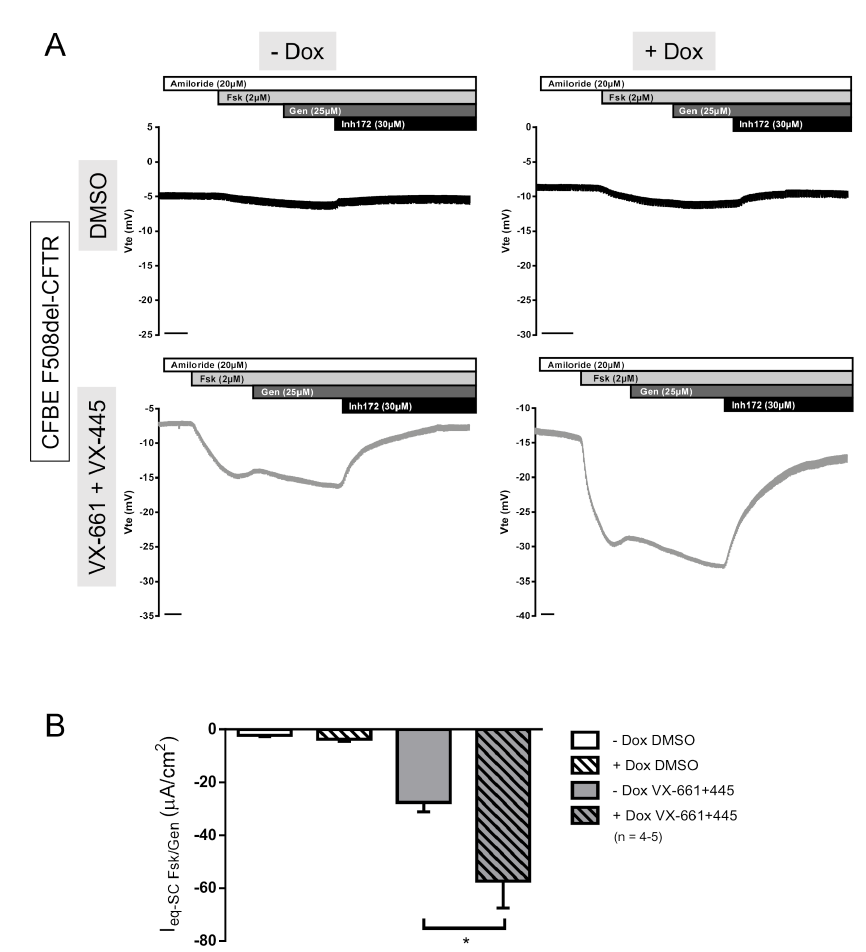
Figure 5. SLC26A9 overexpression heightens F508del-CFTR correction by VX-661 + VX-445. ( A ) Orig- inal Ussing chamber tracings obtained for cAMP-induced Cl − currents (Fsk + Gen) in the absence (top tracings, black) or in the presence (lower tracings, grey) of 5 µ M VX-661 + 2 µ M VX-445 for CFBE F508del-CFTR cells with (right) or without (left) SLC26A9 overexpression (+Dox and − Dox, respectively); ( B ) Summary of I sc-eq currents of CFBE F508del-CFTR +/ − Dox and treated with DMSO vs. VX661 + VX-445. Data are represented by mean ± SEM. (*) indicates significant statistical difference between cells treated or untreated with Dox (unpaired t -test, p ≤ 0.05). The number of filters ( n ) used in the statistical analyses is indicated in the graph. Scale bars in ( A ) represent 1